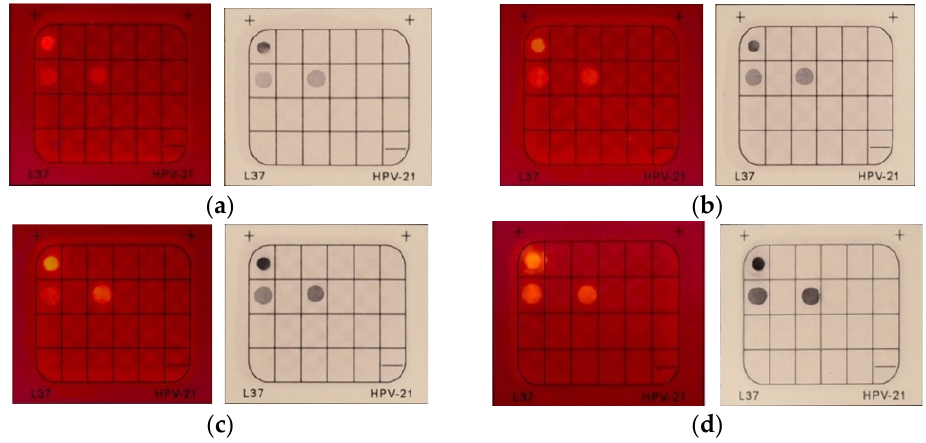
Figure 7. Result comparisons of HCAP and BCIP/NBT on different incubation times, showing ( a ) 30 s, ( b ) 1 min, ( c ) 2 min, and ( d ) 5 min. [HCAP] = 0.1 mM. PCR cycles: 40. Photos were taken under a